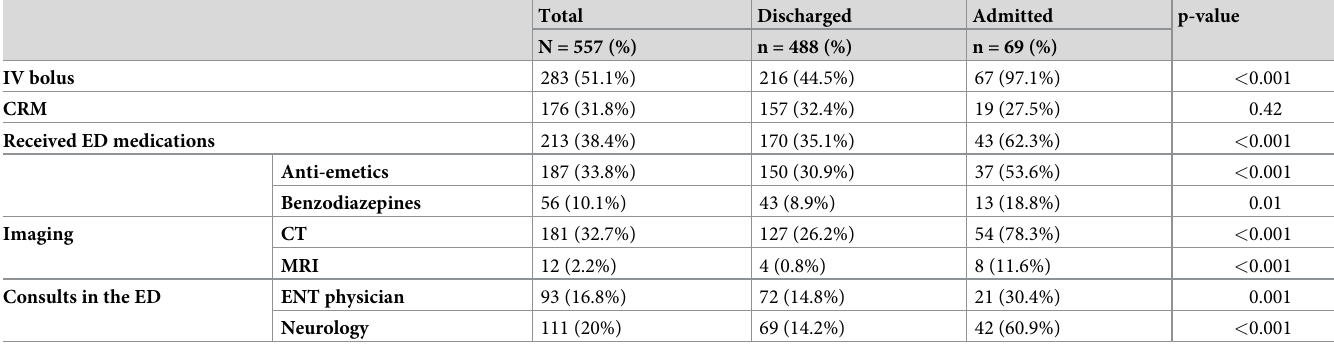
Table 3. ED management of BPPV patients.